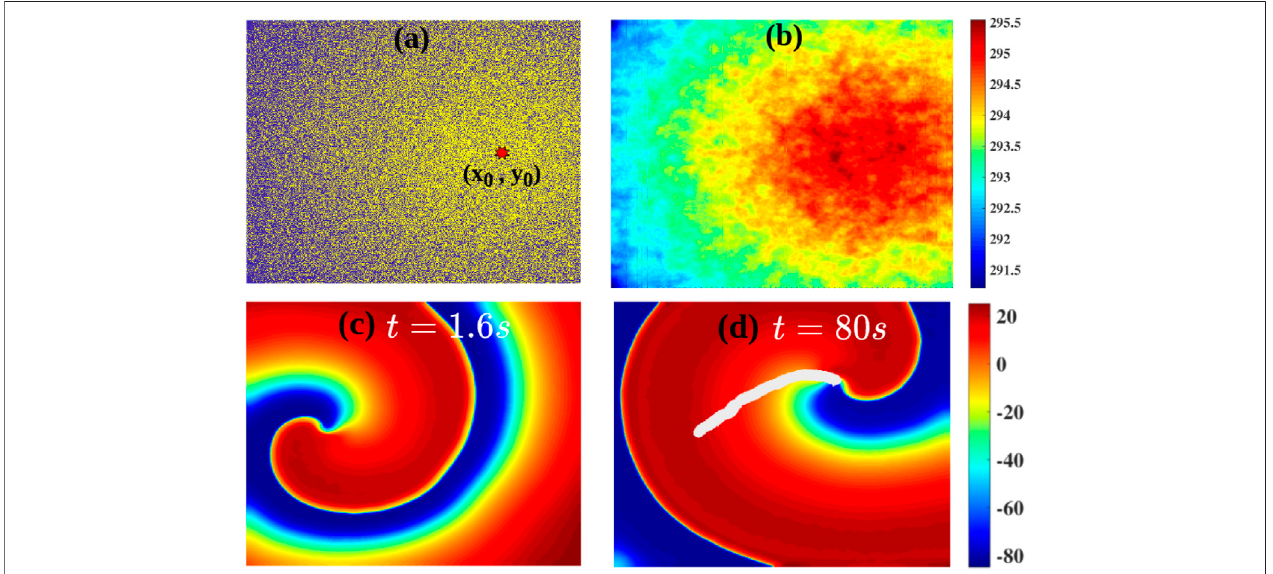
FIGURE 6 | (A) The radially decreasing distribution of the fi broblast density ( Model-II Eq. 5 ) away from a center, marked by a red octagram; yellow indicates fi broblast-myocyte compositesand bluedenoted myocytes. (B) ThedistributionoftheAPDbecauseofthegradientin fi broblastdensity. (C,D) :Pseudocolorplotsof V showingaspiralwaveinthesimulation domain: aspiralinitiatedinthesmall-APDregion,proximaltotheleftboudary,driftstowardsthelarge-APD(low- ω )region.Thetip trajectory of the spiral is marked by the white line.